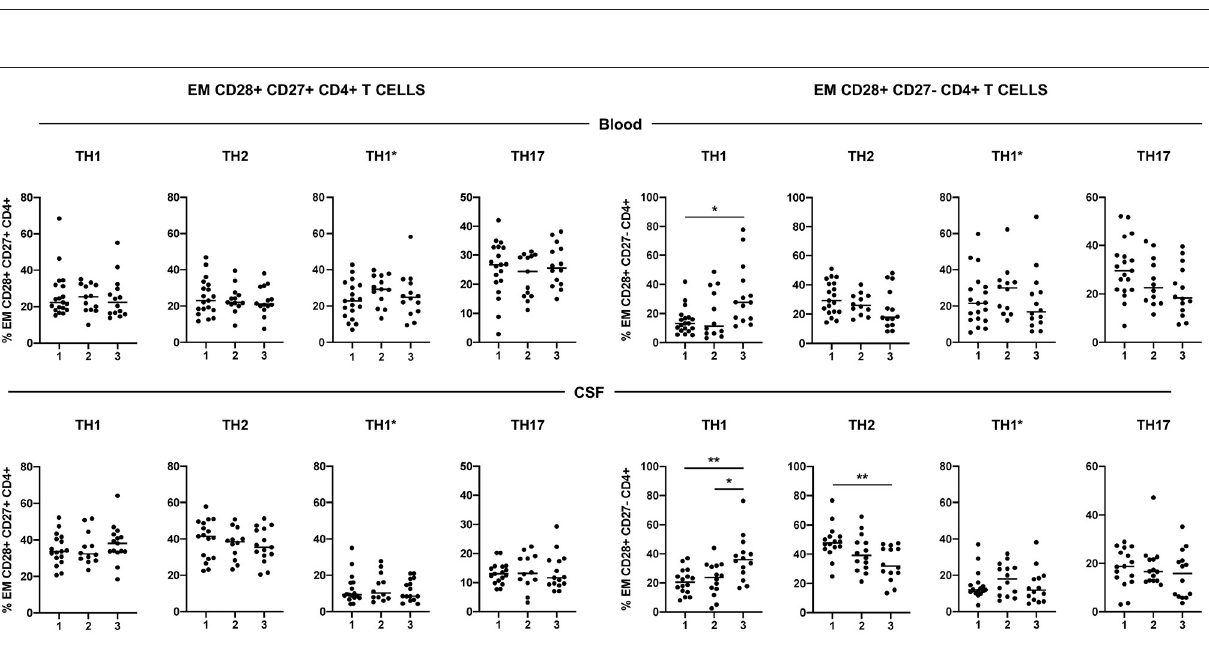
FIGURE 3 | Functional phenotype of CD28 + CD27 + and CD28 + CD27- EM CD4 + T cells. Frequencies of circulating- (upper graphs) and CSF-infiltrating (lower graphs) Th1 (CCR4- CCR6-), Th2 (CCR4 + CCR6-), Th1* (CCR4- CCR6 + ) and Th17 (CCR4 + CCR6 + ) EM CD28 + CD27 + (left graphs) and CD28 + CD27- (right graphs) CD4 + T cells. Each dot in the graphs corresponds to a single patient and lines show means. The Kruskal–Wallis test was used to compare patient groups. Statistical significance (* p < 0.05 and ** p < 0.01) is shown.